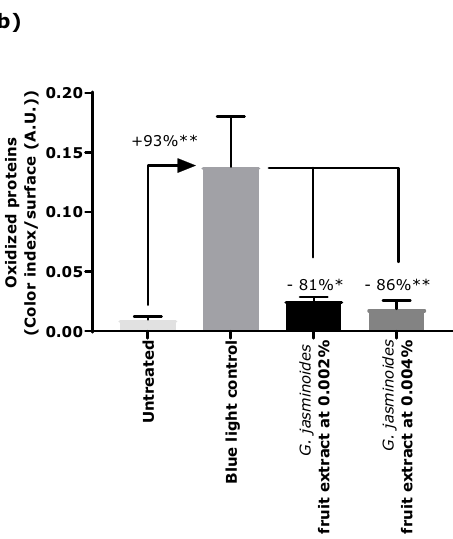
Figure 4. ( a ) Representative images of the oxidized protein staining of human skin explants that were treated or not treated with the extract and stressed or not stressed with 4 repeated blue light exposures at 63.75 J/cm². ( b ) Quantification of oxidized protein immunostaining. Statistical analysis with a Kruskal–Wallis ANOVA, followed by a Mann–Whitney U test in comparison to the blue light control, where * p < 0.05 and ** p < 0.01.